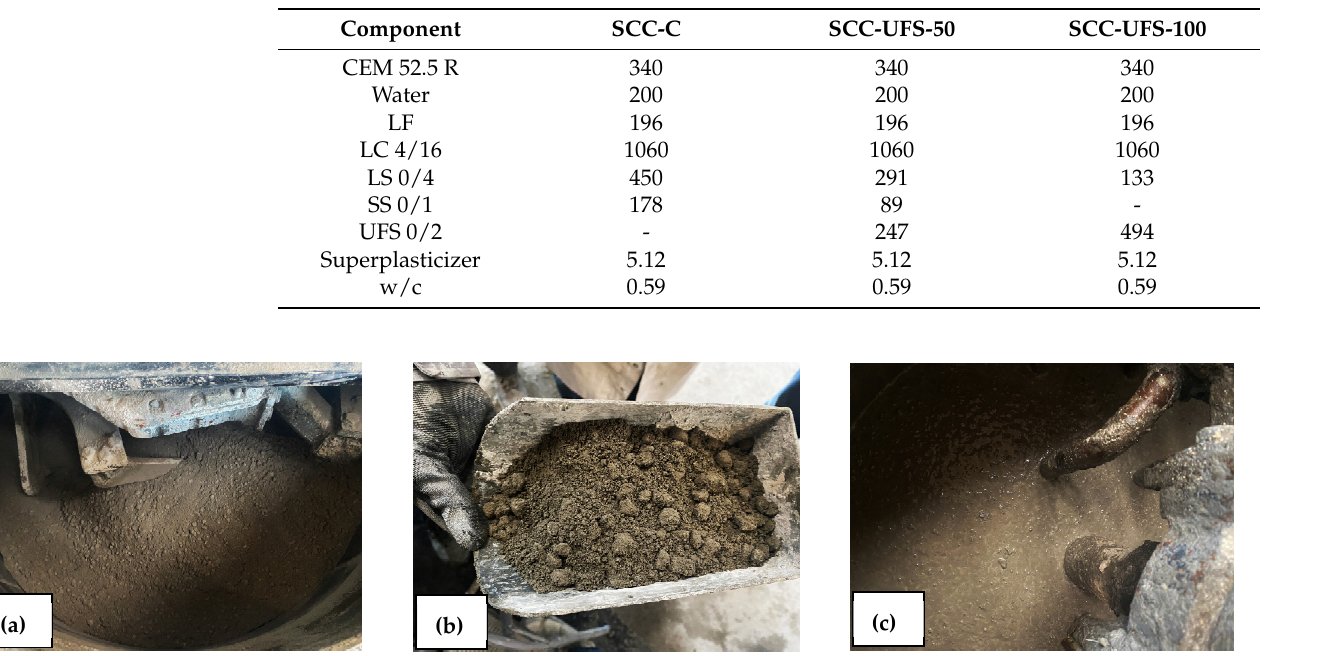
Table 3. Mix proportions (kg/m 3 ).